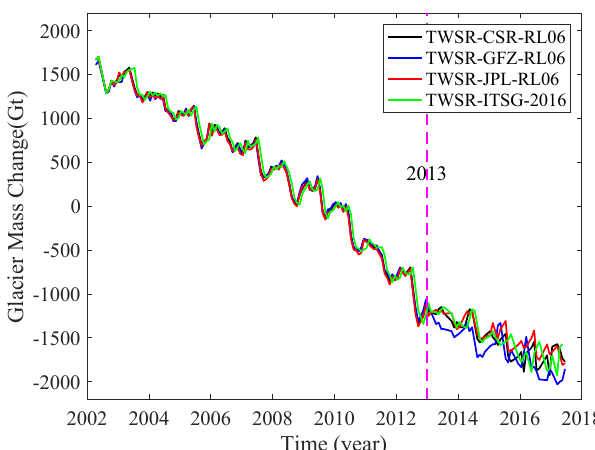
Figure 2. Greenland mass changes from the Geoforschungs Zentrum Potsdam (GFZ), the Center for Space Research (CSR) at the University of Texas in Austin, the Jet Propulsion Laboratory (JPL), and the Institute of Geodesy in Graz (ITSG) processing centers between April 2002 and June 2017, applying the forward modeling technique to suppress the ocean-land leakage effect (the pink dash line represents the beginning of year 2013). TWS-R represents the terrestrial water storage anomalies (TWS) recovered from the forward modeling technique of the Greenland Ice Sheet (GrIS).